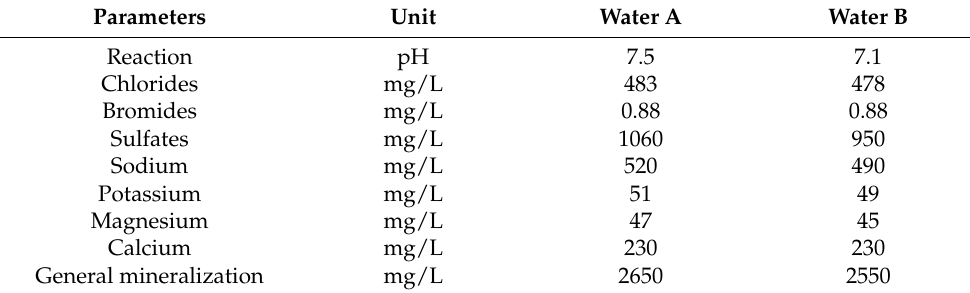
Table 1. Chemical composition of geothermal waters used for